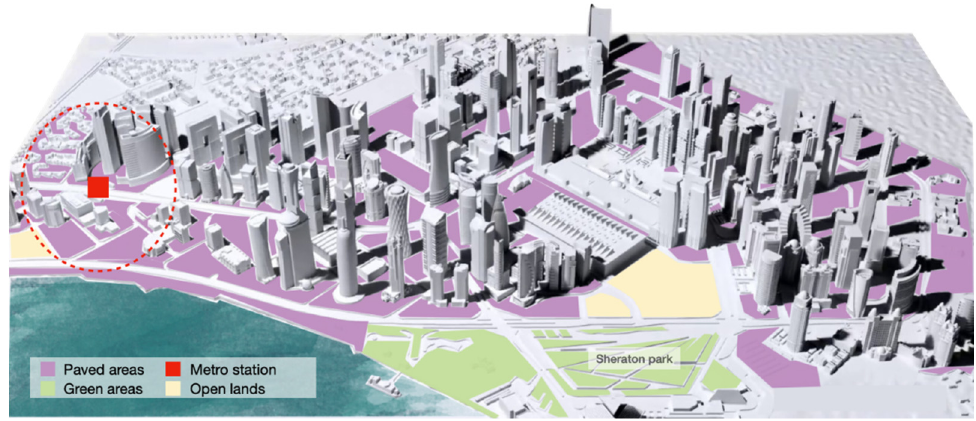
Figure 7. The public realm pattern in West Bay Doha.